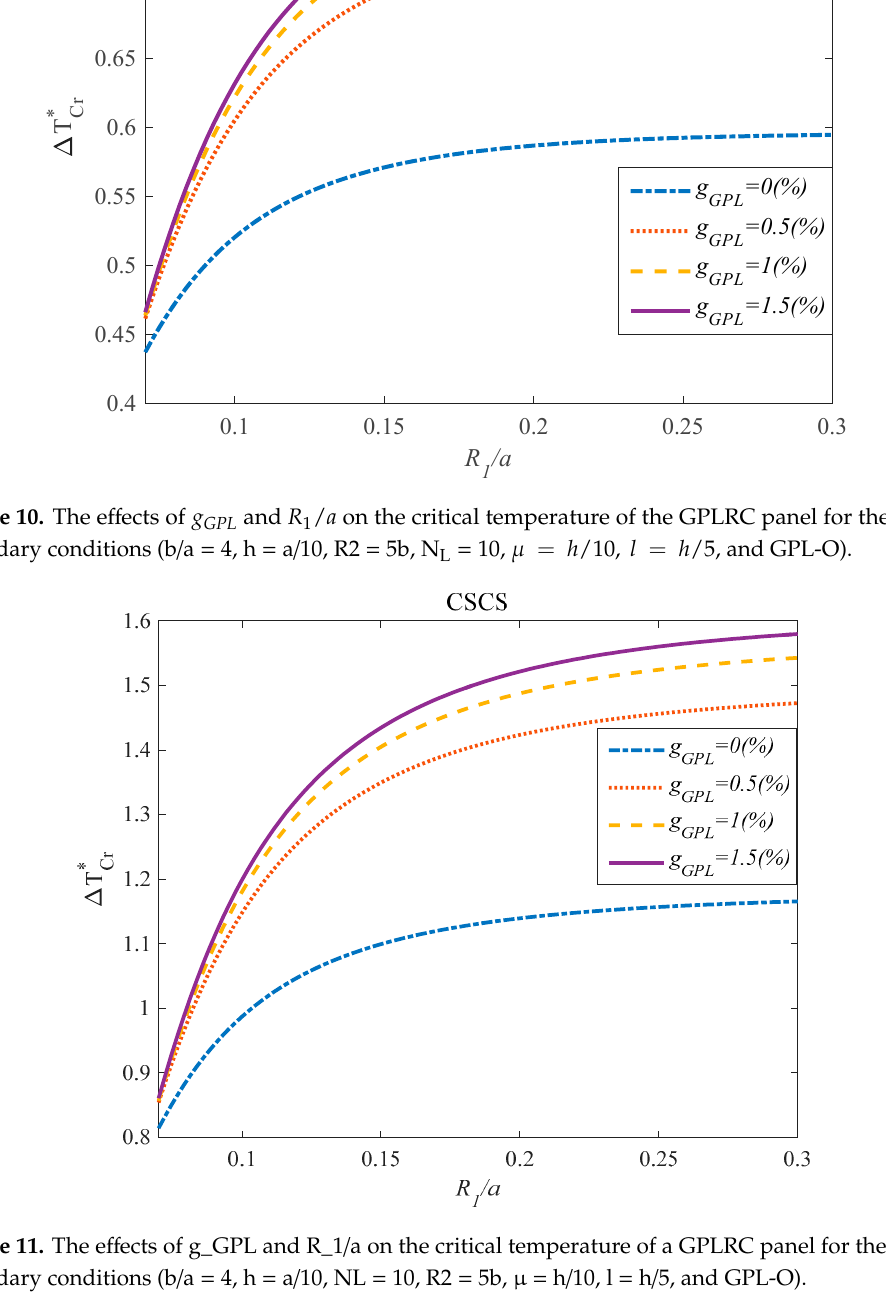
Figure 11. The e ff ects of g_GPL and R_1 / a on the critical temperature of a GPLRC panel for the CSSS Figure 11. The effects of g_GPL and R_1/a on the critical temperature of a GPLRC panel for the CSSS boundary conditions (b / a = 4, h = a / 10, NL = 10, R2 = 5b, µ = h / 10, l = h / 5, and boundary conditions (b/a = 4, h = a/10, NL = 10, R2 = 5b, μ = h/10, l = h/5, and GPL ‐ O).